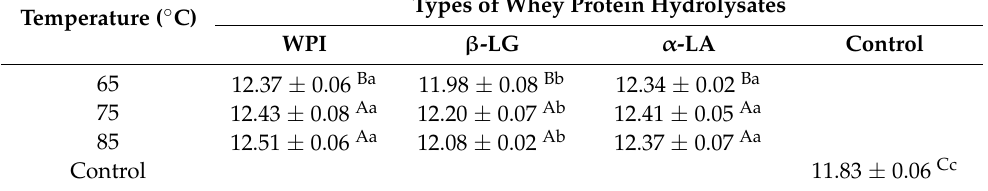
Data are presented as mean ± standard deviation ( n = 6). The different letters A,B,C in the same column indicate a significant difference at p < 0.05. The different letters a,b,c in the same row indicate a signif- icant difference at p < 0.05.